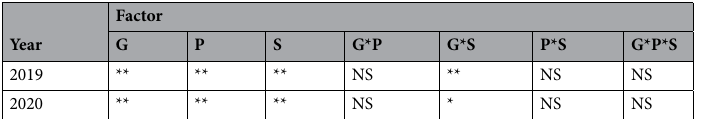
Table 3. ANOVA of effect of planting patterns, super absorbent polymers and growth period on soil water storage in 2019–2020. **Significant at 0.01 level, * significant at 0.05 level, NS means no significant. G, P and S represent growth stage, planting pattern and super absorbent polymer.